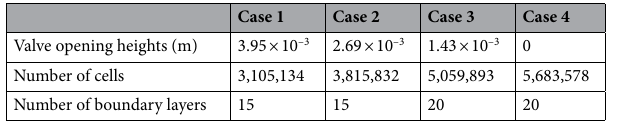
Table 1. Mesh size.